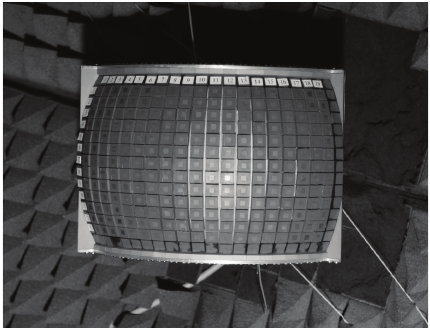
Figure 4: Prototype of spherical conformal phased array antenna.